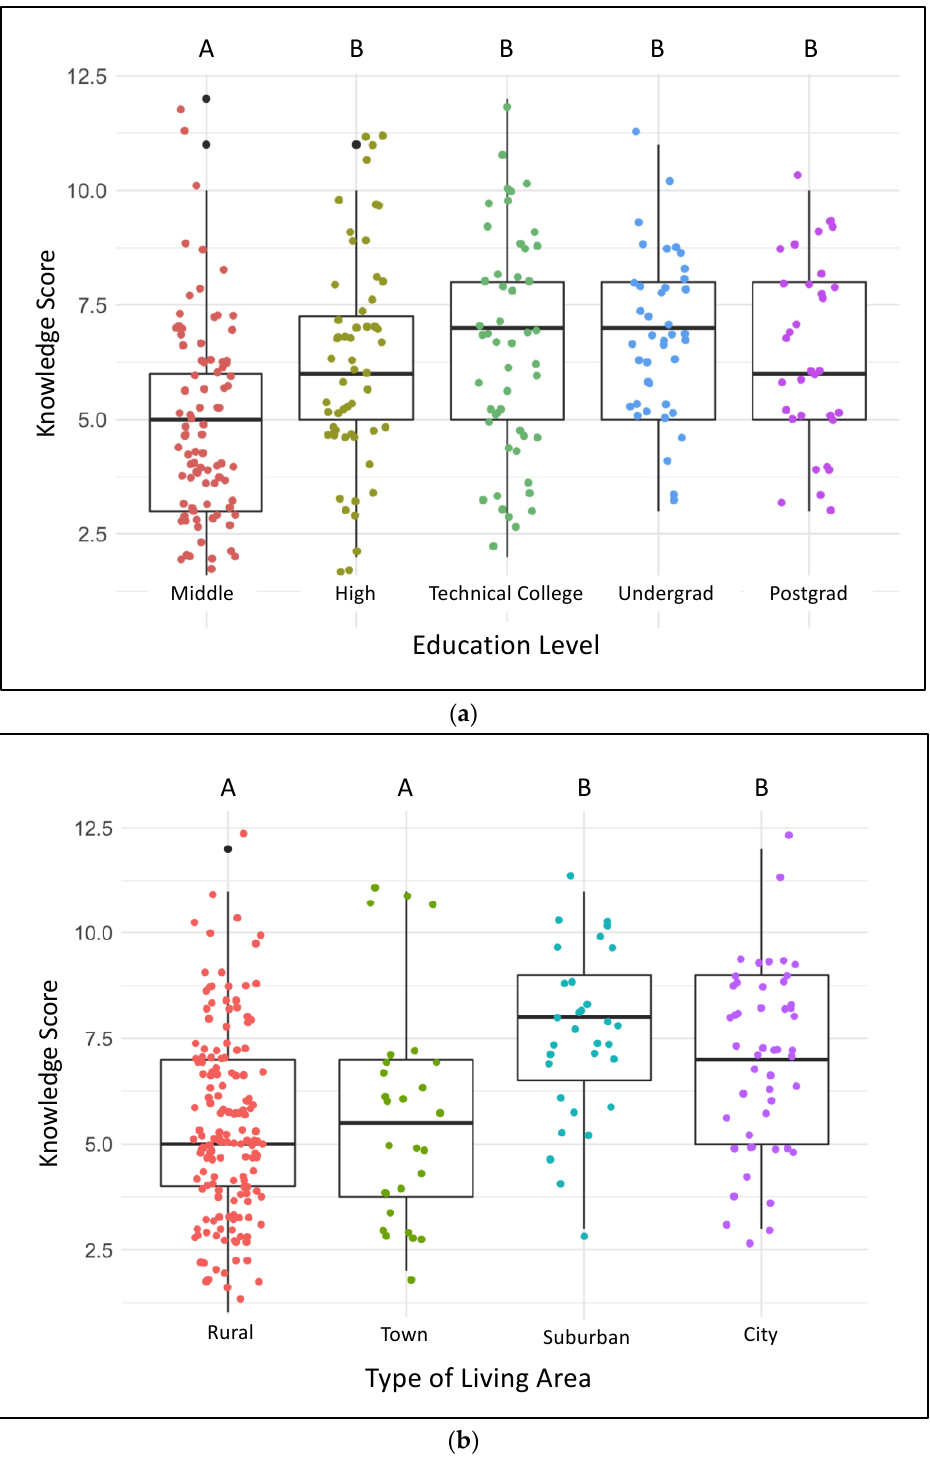
Figure 2. Boxplots of Knowledge Score for respondents with different education levels ( a ) and living areas ( b ). Uppercase letters indicate differences between groups (groups with different letters are significantly different at p < 0.05 from each other). Individual datapoints within the group are depicted.